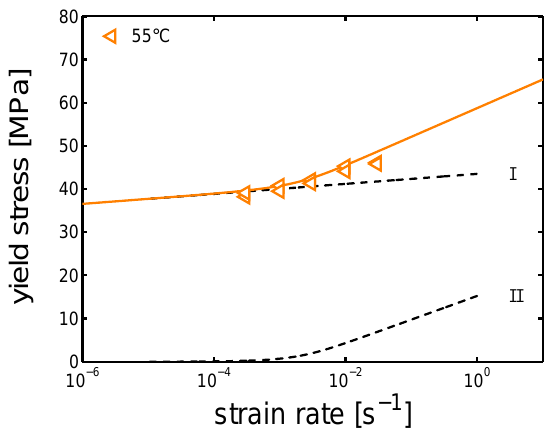
Figure 6. Example of two processes contributions. Yield stress versus strain rate at 55 °C; the black dashed lines are the two contributions separated (processes I and II).